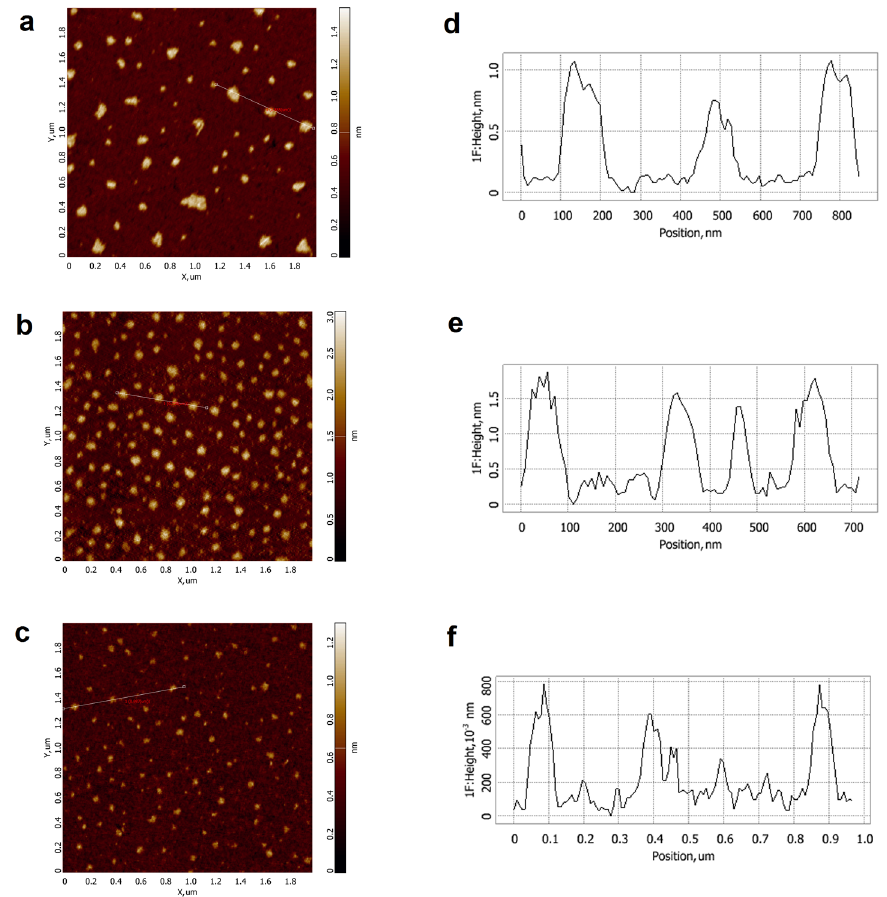
Figure 1. Typical AFM images ( a – c ) and cross-section profiles ( d – f ) of mica-adsorbed HRP, obtained in control experiments ( a , d ) and after 40-min incubation of the HRP solution in the vicinity of the apex of the pyramid ( b , e ) or in the center of its base ( c , f ). The cross-section profiles correspond to the lines shown in the respective AFM images. The images were obtained using NOVA Px software (ver. Nova_3.4_20014; NT-MDT, Moscow, Zelenograd,